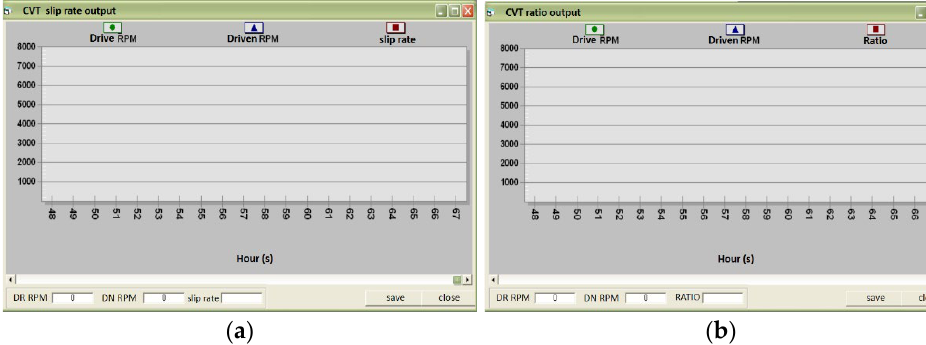
Figure 17. Screenshot: ( a ) slip ratio; ( b ) transmission ratio.